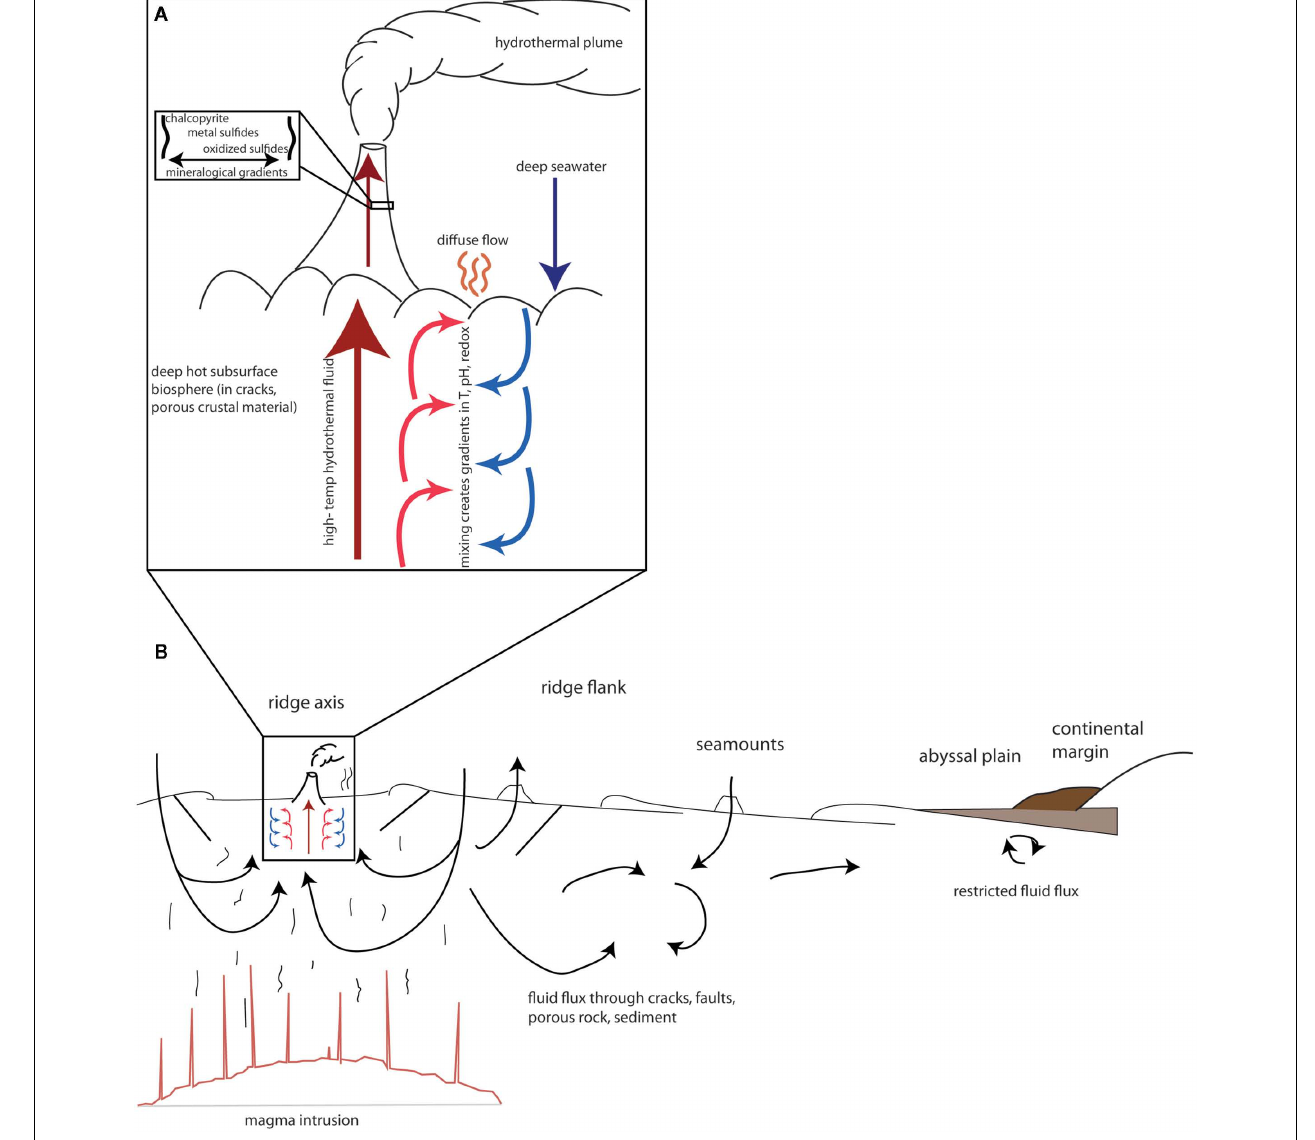
FIGURE 1 | Schematic of fluid flux and gradient formation in (A) hydrothermal systems and (B) various regimes of the deep biosphere. Arrows represent fluid flux. Based on figures in Edwards et al. (2011), Huber et al. (2003), and Baross and Hoffman (1985).